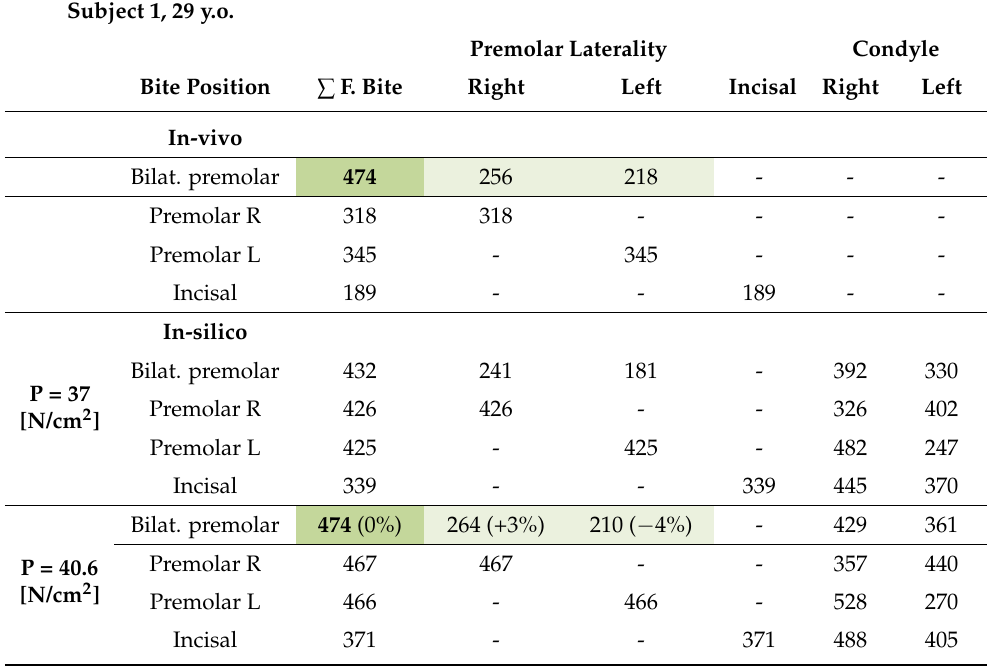
Table 3. Bite registrations through the bite force experiments (In vivo) and finite element analyses (In silico). All the presented forces acted orthogonally to the Frankfurt horizontal plane. The boxed values were matched to determine the PS intrinsic strength